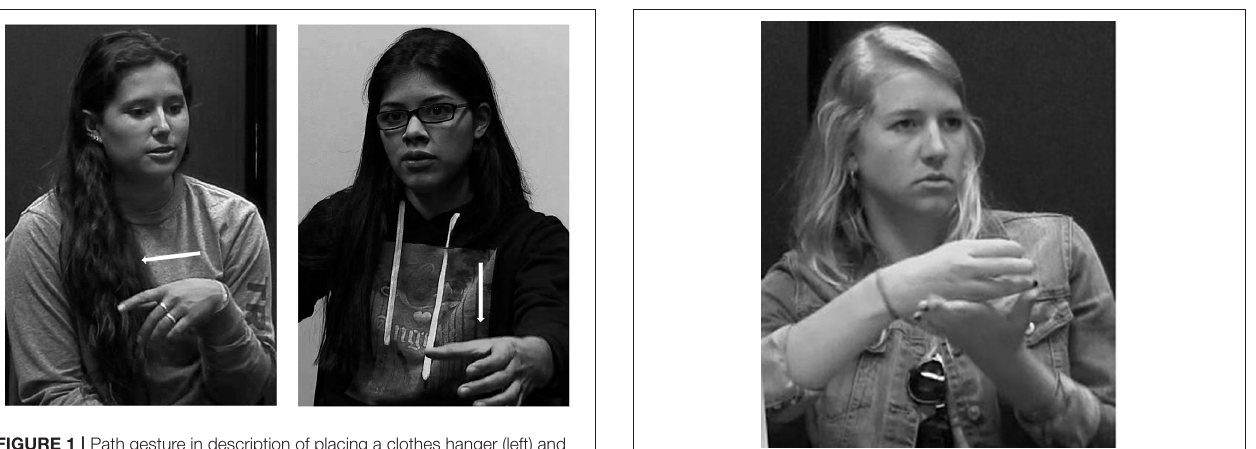
FIGURE 1 | Path gesture in description of placing a clothes hanger (left) and figure + path gesture in description of placing a speaker (right). gesture including both information about the figure object and the path of the placement event.